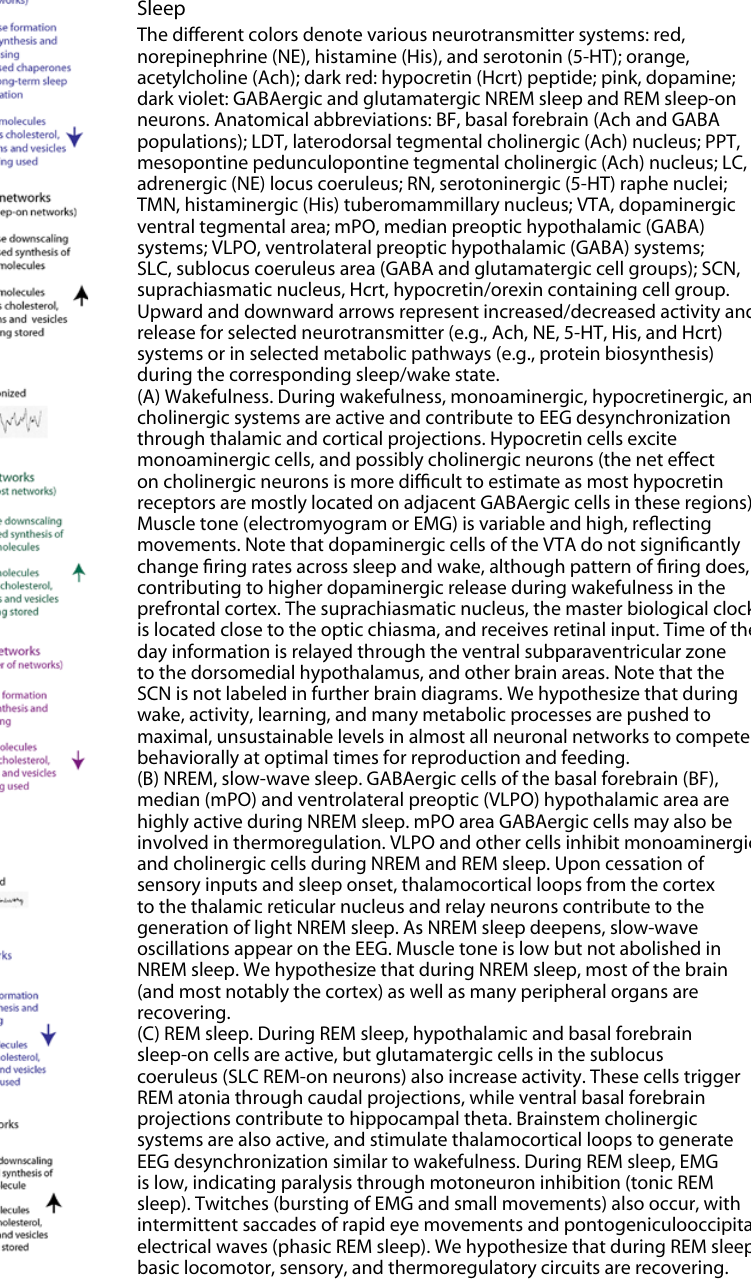
Figure 1. Activity of Major Neural Networks and Hypothesized Molecular Processes Occurring During Wake, NREM Sleep, and REM Sleep The different colors denote various neurotransmitter systems: red, norepinephrine (NE), histamine (His), and serotonin (5-HT); orange, acetylcholine (Ach); dark red: hypocretin (Hcrt) peptide; pink, dopamine; dark violet: GABAergic and glutamatergic NREM sleep and REM